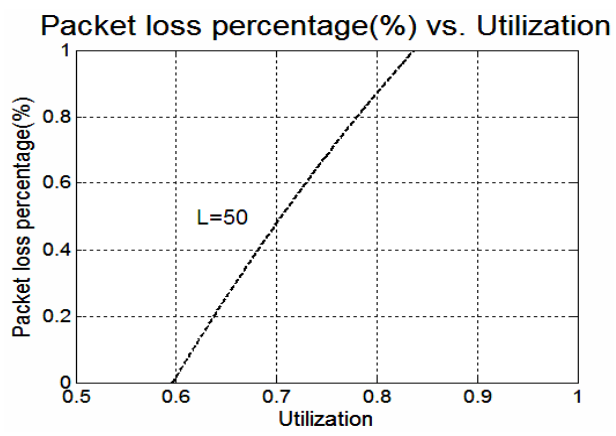
Figure 5. Packet loss percentage vs. Utilization.